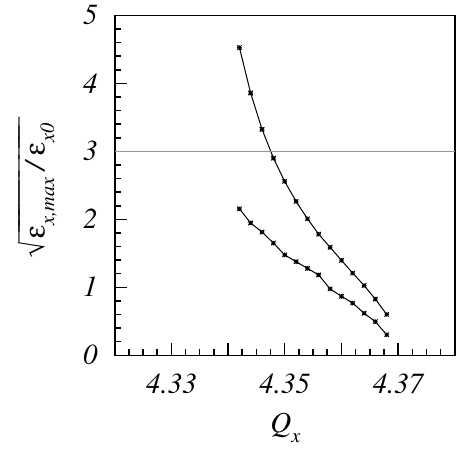
FIG. 10. Position of the 3rd order island edges in units of rms beam size as a function of the working point Q x . The green line is located at the edge of the beam.